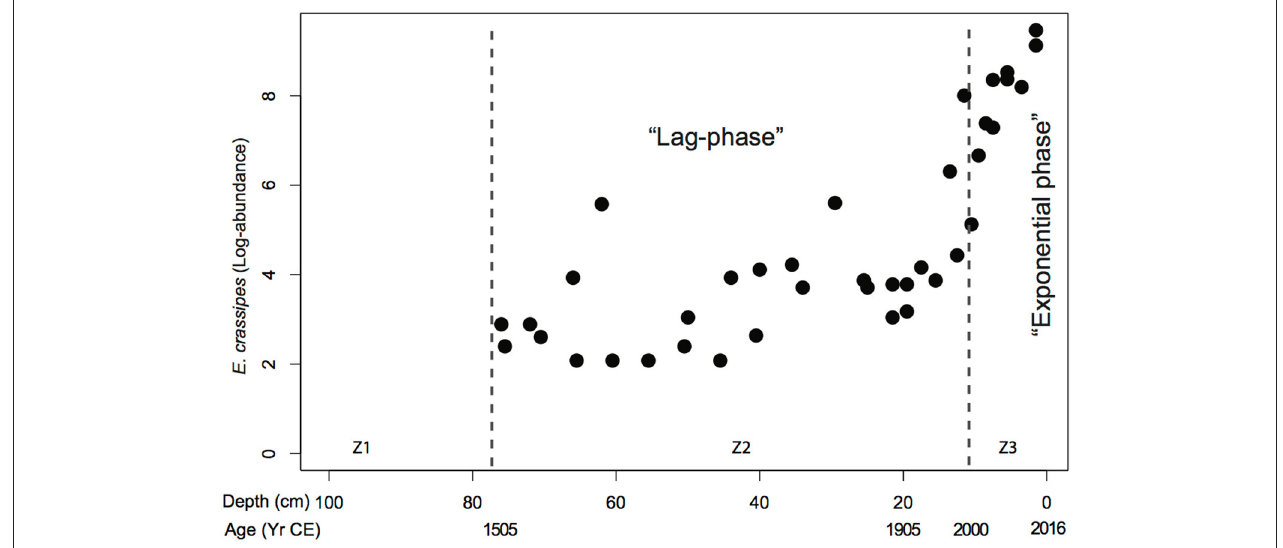
FIGURE 8 | Piecewise regression analysis of Eichhornia crassipes macrofossil abundances from the cores LFUQ-M1 and LFUQ-WH1, showing two phases of spread (lag-phase and exponential phase) with a highly significant ( P < 0.0001) breakpoint at 11.5cm (1995). Dotted lines represent zones of macrophyte change revealed by univariate regression tree analysis. Z1 CE c. pre-1506; Z2 CE 1506-1904; Z3 1905